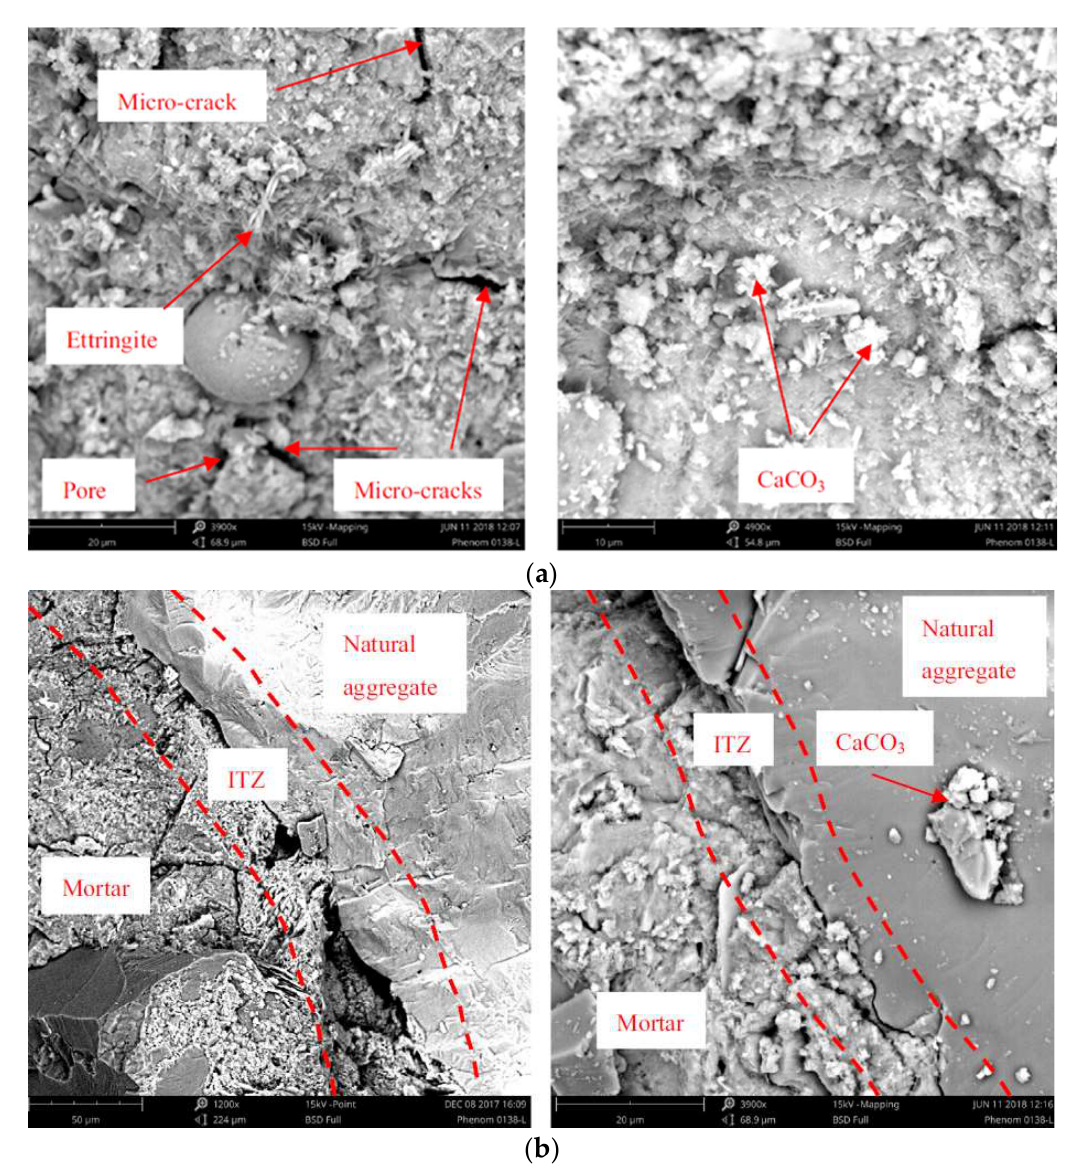
Figure 2. SEM images of ( a ) attached mortar and ( b ) ITZ in RCA before and after treatment [6]. Reproduced with permission from [6], Elsevier, 2019.